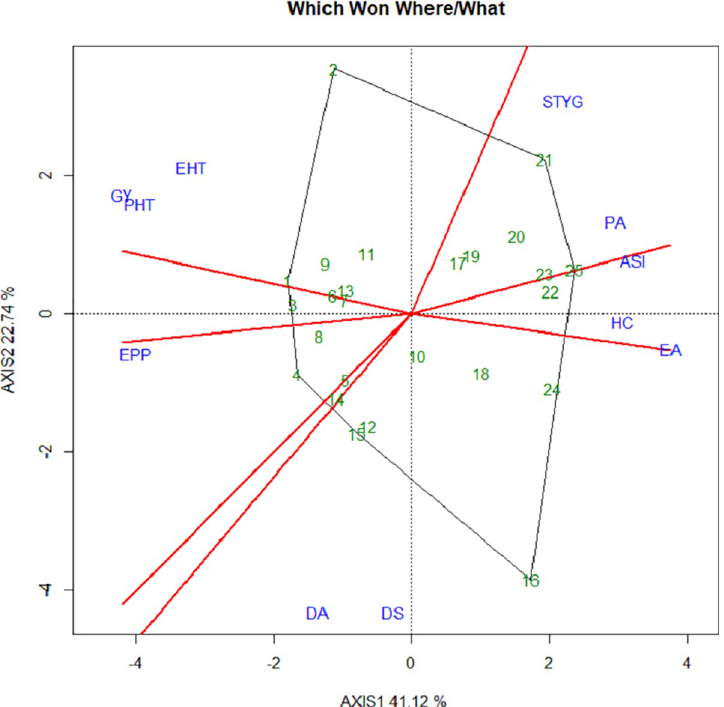
Fig 1. A ‘which won where/what genotype-by-trait biplot view of 25 (15 best and 10 worst) selected inbred lines evaluated under LN stress. GY = grain yield (kg ha -1 ), DA = days to 50% anthesis, DS = days to silking, ASI = anthesis-silking interval, STYG = stay-green characteristic, PA = plant aspect, PHT = plant height, EHT = ear height, HC = husk cover EA = ear Aspect, EPP = ears per plant. 1 = TZEEQI 394; 2 = TZEEIORQ 73A; 3 = TZEEIORQ 22A; 4 = TZEEIORQ 4; 5 = TZEEQI 408; 6 = TZEEIORQ 17; 7 = TZEEIORQ 5; 8 = TZEEIORQ 63A; 9 = TZEEQI 392; 10 = TZEEQI 357; 11 = TZEEIORQ 61A; 12 = TZEEIORQ 72A; 13 = TZEEQI 393; 14 = TZEEIORQ 34; 15 = TZEEIORQ 3; 16 = TZEEQI 368; 17 = TZEEQI 359; 18 = TZEEIORQ 67; 19 = TZEEIORQ 13A; 20 = TZEEIORQ 50B; 21 = TZEEQI 351; 22 = TZEEQI 411; 23 = TZEEIORQ 50; 24 = TZEEQI 363; 25 = TZEEIORQ 6A. https://doi.org/10.1371/journal.pone.0252506.g001 Polymorphic information content (PIC) ranged from 0.019 to 0.535 with a mean of 0.290. The average heterozygosity for the 1691 markers was 0.070 and ranged from 0.00 to 0.590. The mean pairwise genetic distance was 0.508 and varied between 0.0098 and 0.615 (Fig 2). Gener- ally, the genetic distances were higher between yellow and orange lines. The lowest genetic dis- tance was detected between TZEEIORQ 50 and TZEEIORQ 50B. These two inbred lines have orange endosperm, are related by descent, and shared similar selection history based on their pedigree information (S1 Table). The highest genetic distance was detected between TZEEQI 16 and TZEEIORQ 6A followed by TZEEQI 393 and TZEEIORQ 9A. These pairs of lines dif- fered both in endosperm color and the source populations from which they were extracted. In